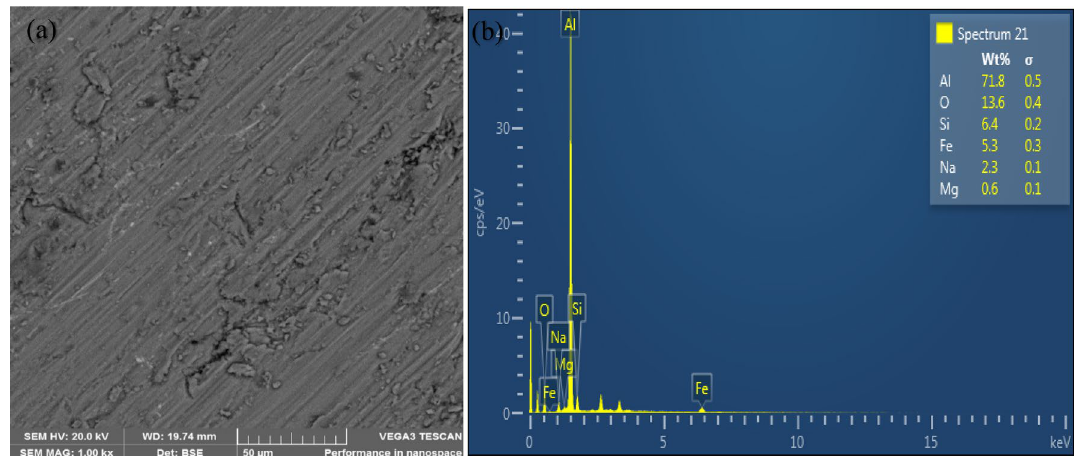
Figure 6. Representative morphology of reinforced composite (A1) ( a , b ).